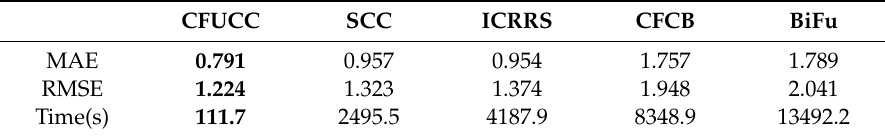
Table 5. Performance comparisons among di ff erent methods for Experiment 2.